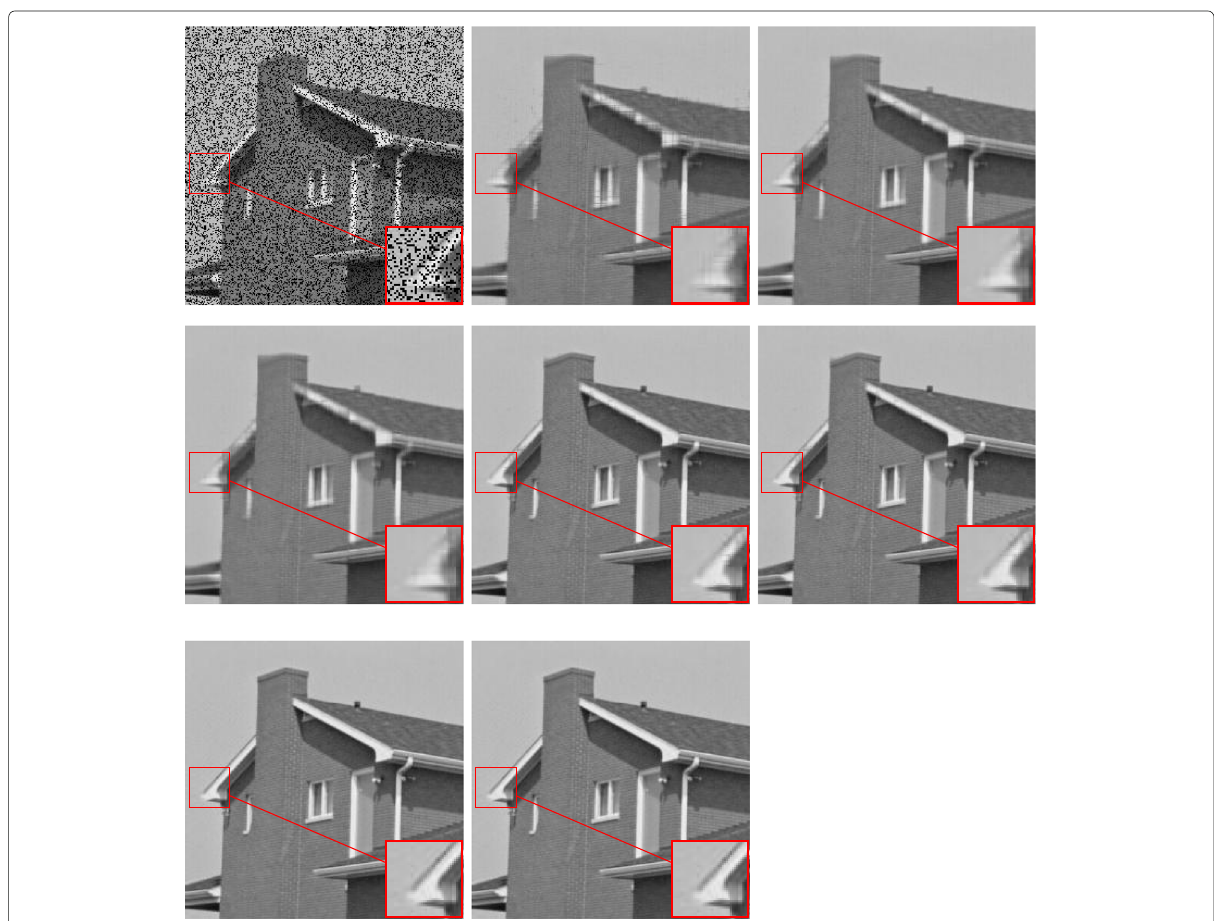
Fig. 5 Results obtained for image “house” using the different methods. From left to right, the order of the images is as follows: simulated image with missing data, recovered image using FPC algorithm, recovered image using ALM algorithm, recovered image using IALM algorithm, recovered image using PPG algoritm, recovered image using PG algorithm, recovered image using SVT with power method, and finally the recovered image using our proposed